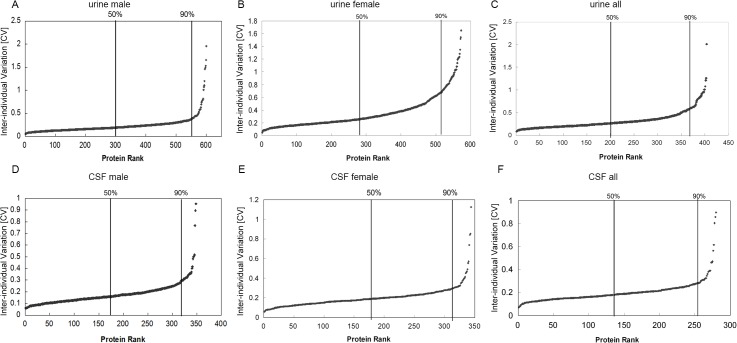
Inter-individual variation of urinary and CSF proteomes.The inter-individual variations of male (A), female (B), and both male and female (C) urinary proteomes are shown. The inter-individual variations of male (D), female (E), and both male and female (F) CSF proteomes are shown. The proteins with median and top 10% inter-individual CVs are annotated in the figures.